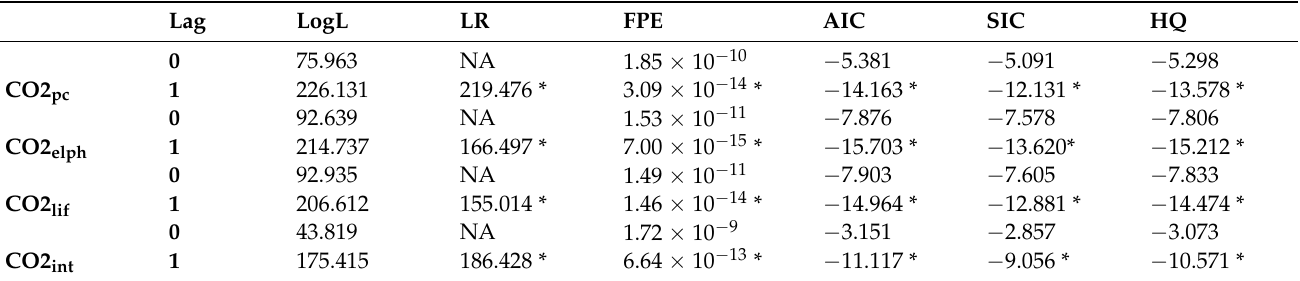
Table 4. Criteria of selecting lag length for